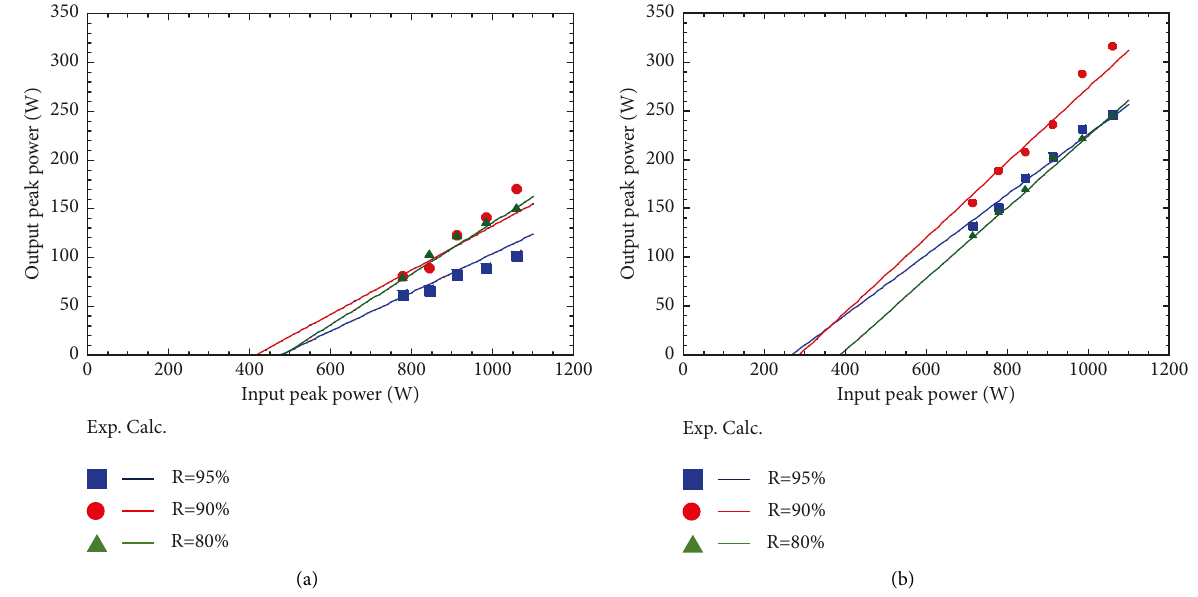
Figure 11: Calculated output laser peak power. (a) Cr/Cr/Nd :YAG ceramic laser. (b) Ce/Nd:YAG ceramic laser.